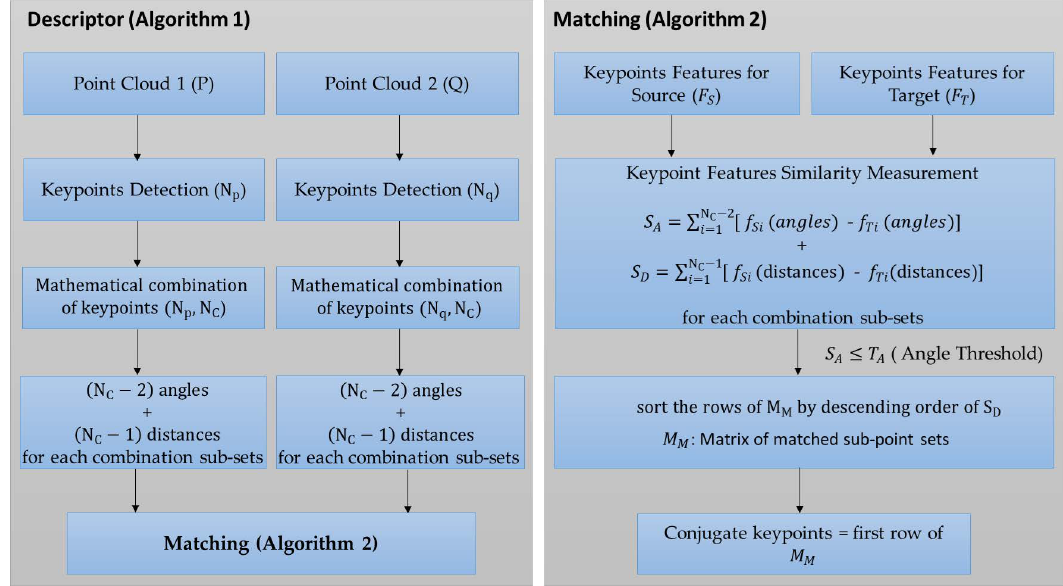
Figure 10. The fundamental processing steps of the descriptor and matching algorithms of the proposed algorithm in the study.